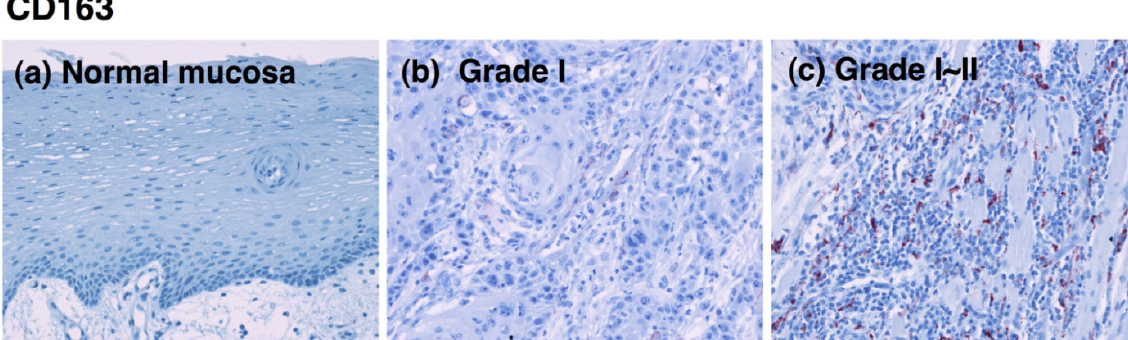
Figure 3. Immunohistochemical staining of OSCC with the anti-CD163 antibody. Immunoreactivity for the anti-CD163 antibody in normal oral mucosa ( a , original magnification: 100×) and different pathological grades of OSCC ( b-f , original magnification: 200×) are shown. No positive cells were observed in normal mucosa ( a ); CD163 + cells were mainly observed in the tumor stroma in grade I OSCC ( b ); and the distribution of CD163 + cells increased in the tumor nest with increasing OSCC grade ( d-f